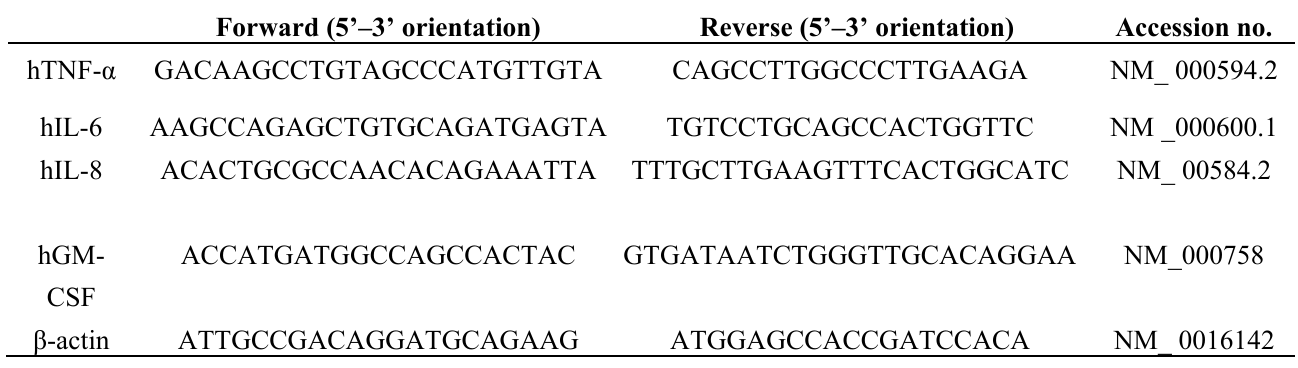
Table 1. Sequences of oligonucleotide primers designed for real-time